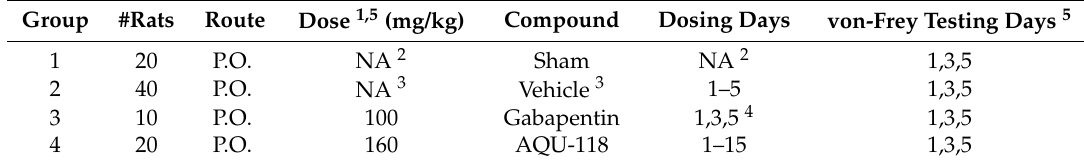
Table 1. Protocol for SNL study using male Sprague-Dawley rats.